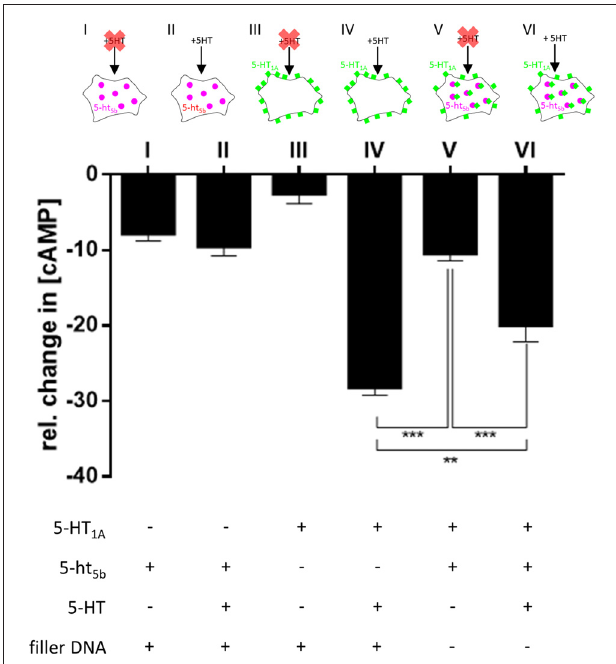
FIGURE 7 | Physiological consequences of 5-HT 1A :5-ht 5b co-expression. To test whether translocation of 5-HT 1A by 5-ht 5b effects cyclic adenosine monophosphate (cAMP) signaling, we measured the cellular cAMP level under various conditions. To measure the decrease of cAMP, 50 nM Forskolin was added to all cells before the start the experiment to increase cAMP levels. Mock-transfected cells treated with Forskolin and stimulated with 1 µ M 5-HT served as control and were set to 100%. In all experiments, cells were transfected with an equimolar amount of DNA. To keep the amount of DNA the same in experiments with only one receptor, a filler plasmid was co-transfected. Expression of 5-ht 5b without stimulation with 5-HT decreased cAMP by − 7.75% ± 1.012 (I), while addition of 5-HT did not enhance the reaction ( − 9.46% ± 1.296; II). Expressing 5-HT 1A in cells had no effect on cAMP levels without stimulation ( − 2.49% ± 1.366; III), but adding 5-HT decreased cAMP by − 28.12% ± 1.096 (IV). Co-expression of 5-HT 1A and 5-ht 5b together without stimulation by 5-HT lead to a drop in cAMP by − 10.37% ± 1.029 (V). Adding 5-HT to co-expressing cells dropped the cAMP level by − 19.91% ± 2.219 (VI). Asterisks indicate significance ( ∗∗ p ≤ 0.01; ∗∗∗ p ≤ 0.001; one-way-ANOVA with Bonferroni’s post-test for multiple